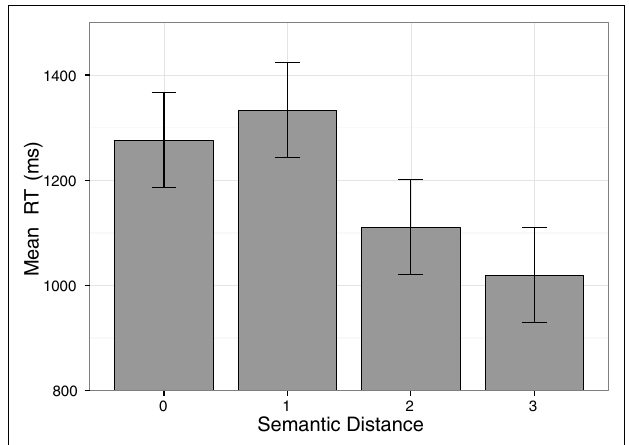
FIGURE 1 |The cross-modal semantic distance effect between tactile and symbolic numerosities. The larger the semantic distance between both numerosities, the shorter the mean response time. Error bars represent 95% within-subject confidence intervals (cf. Loftus and Masson,